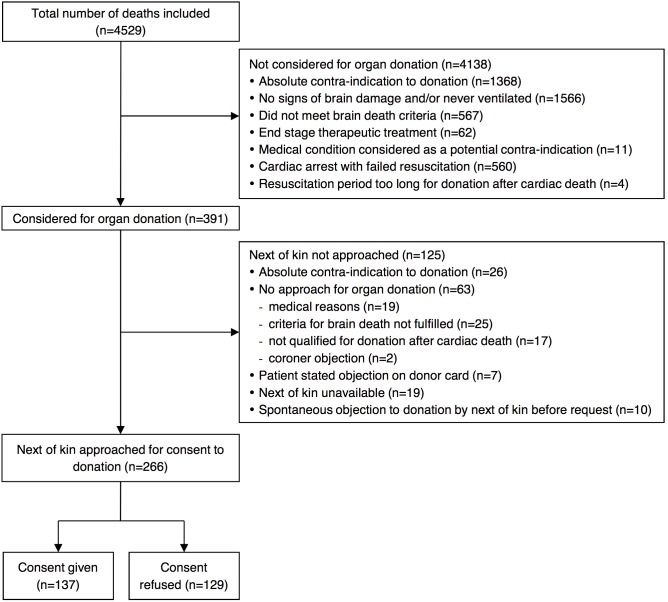
Study flow chart.